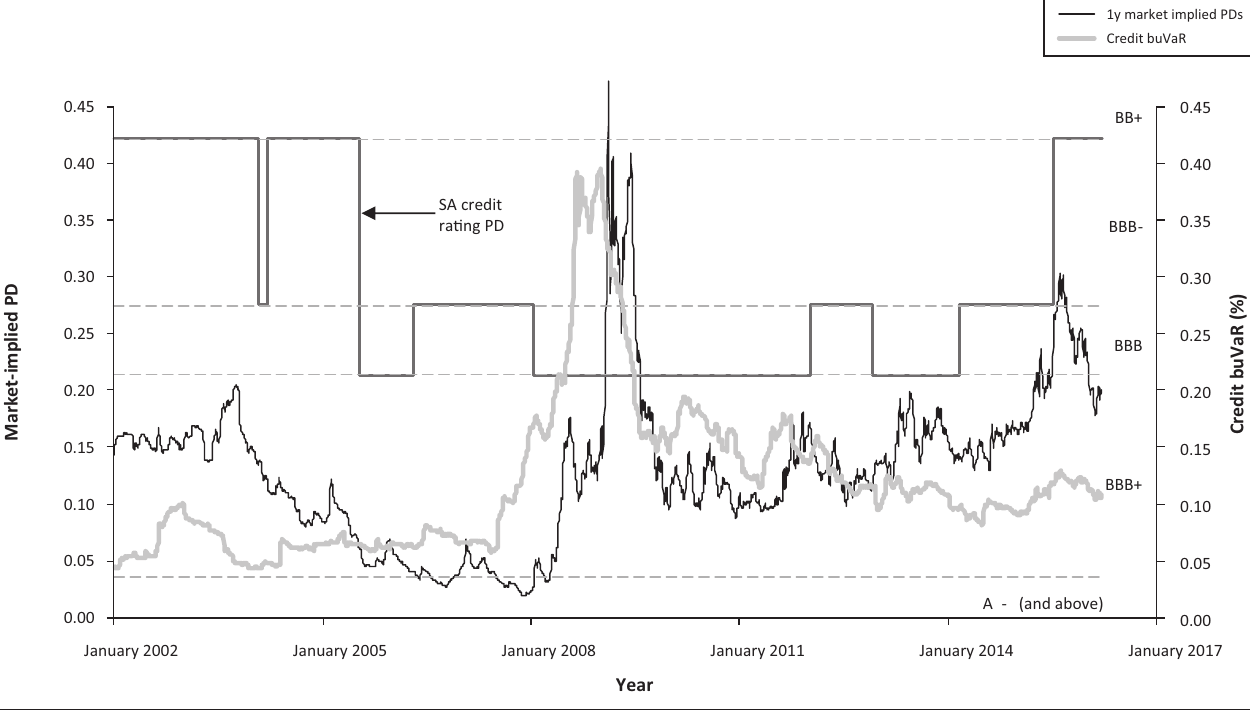
FIGURE 11: Market-implied probabilities of default (using Equation 9 and five-year credit default swap spreads from Figure 1), South African credit rating (mapped to relevant probability of default) and bubble value at risk on the same